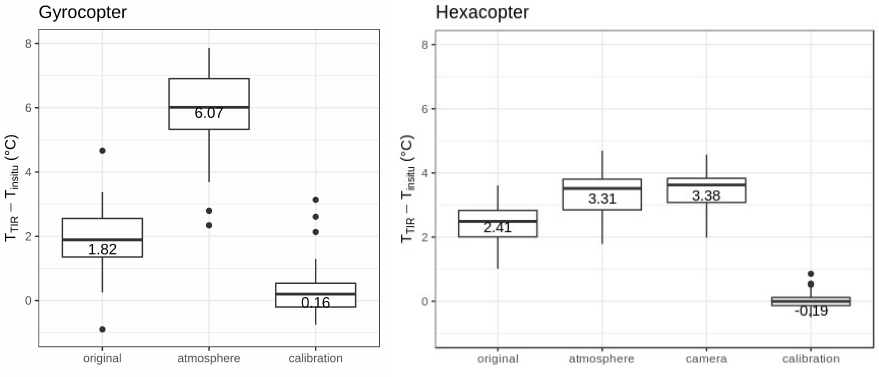
Figure 7. Boxplot and mean of the temperature difference between TIR temperatures ( T TIR ) and in situ measurements ( T insitu ) in the original datasets and after the respective correction